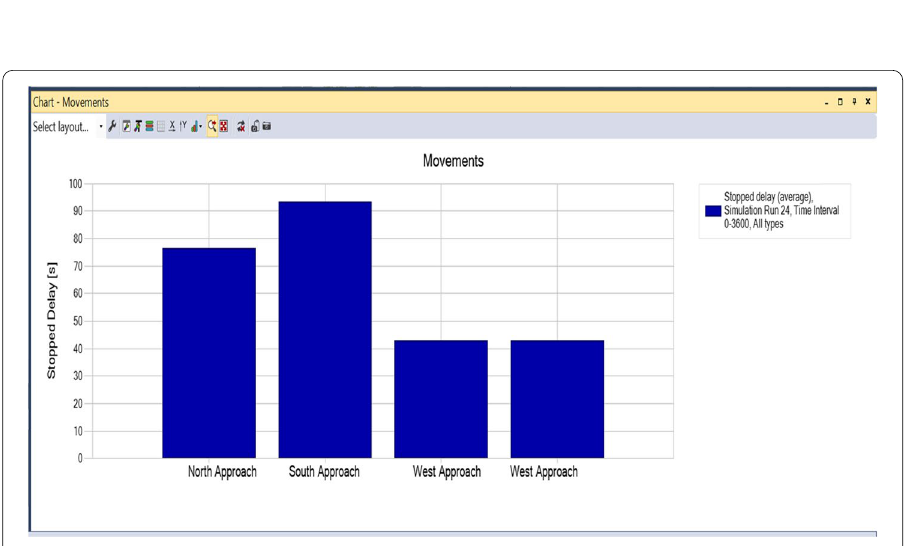
Fig. 4 Stopped delay results for VISSIM simulation